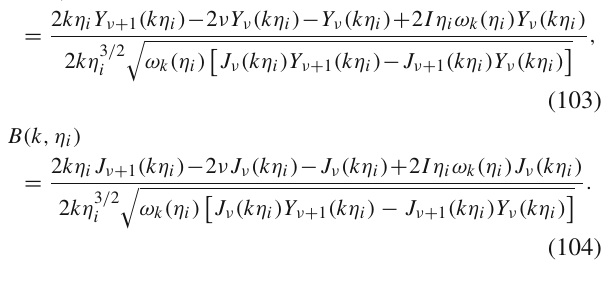
appropriate time scale is in terms of H